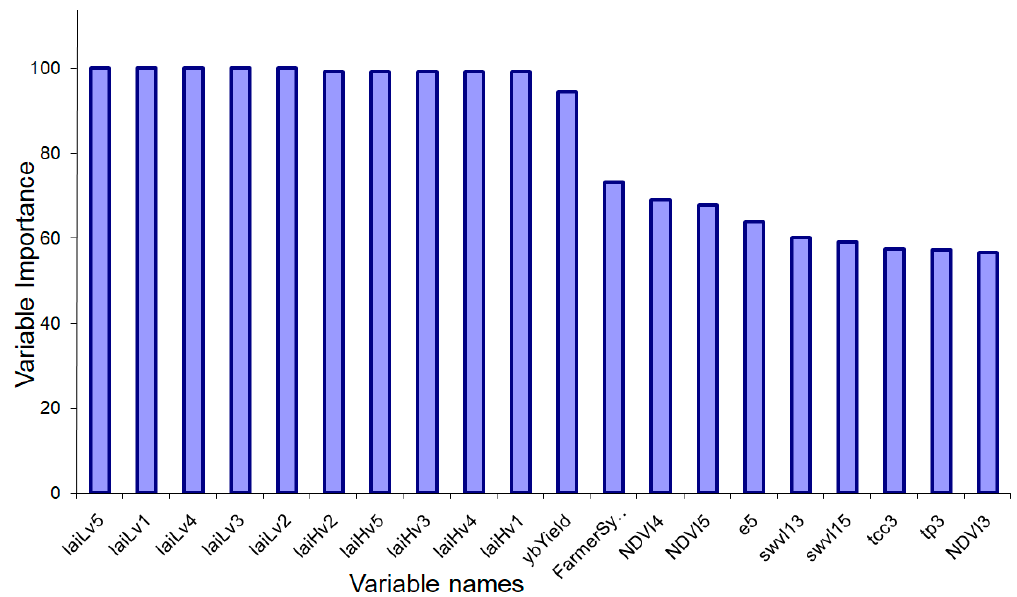
Figure 4. Variable importance of the svmP model, 5-month scenario, and summer cycle using bootstrapping method (25 repetitions) and one iteration.